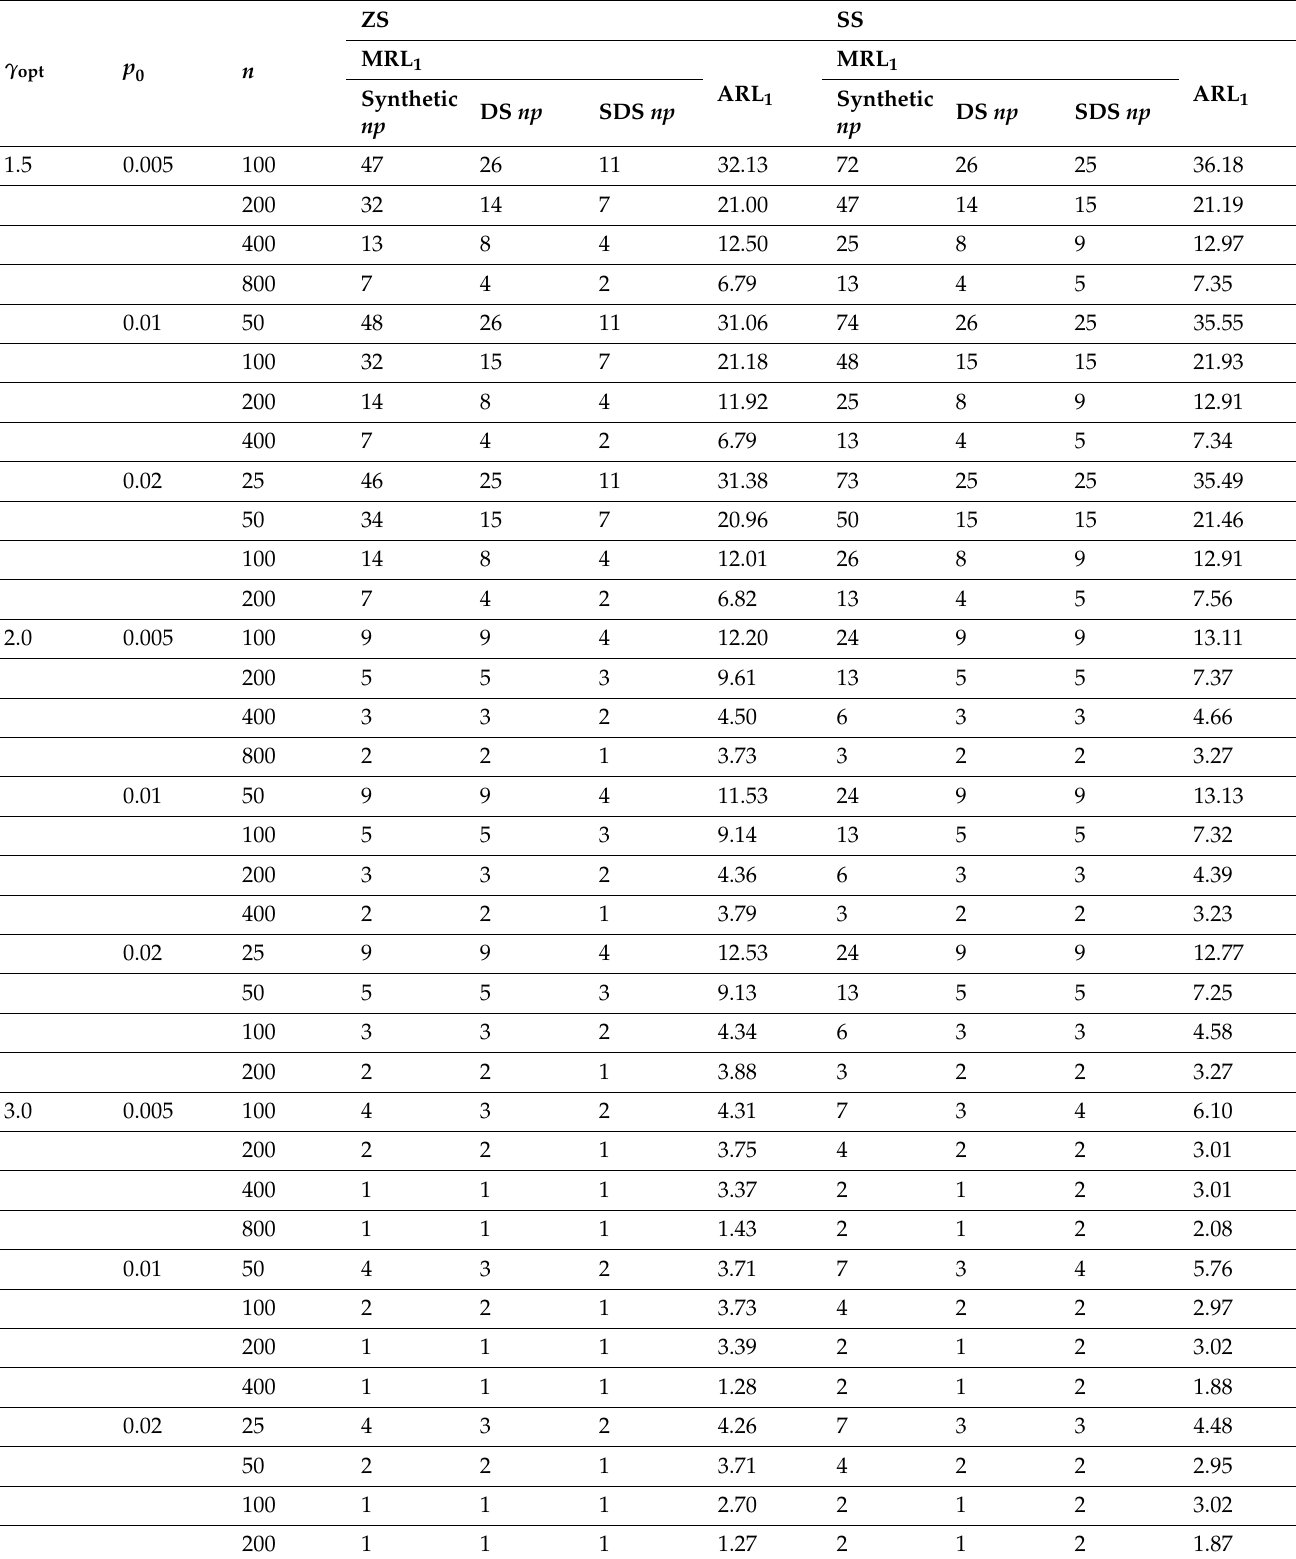
Table 2. MRL 1 comparison between SDS np , DS np and synthetic np charts with associated ARL 1 of the SDS np chart, in ZS and SS modes, when MRL 0min =